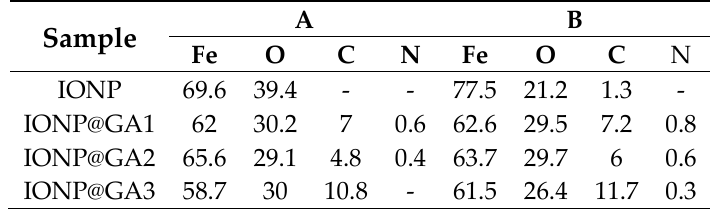
Table 2. EDX elemental composition ( A ) Before DPPH assay ( B ) After DPPH